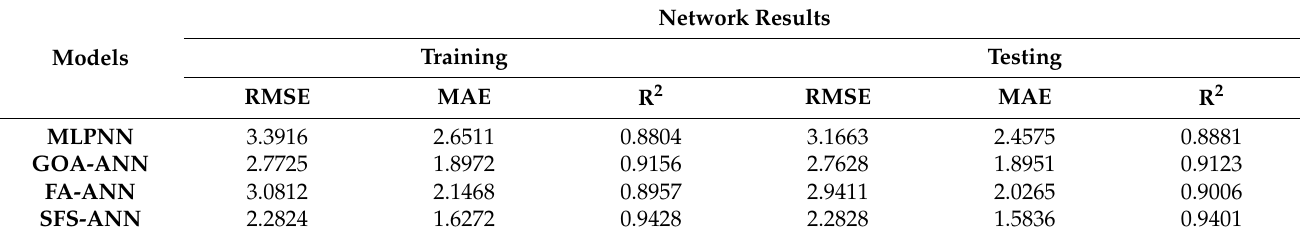
Table 3. A summary of accuracy indices obtained in this